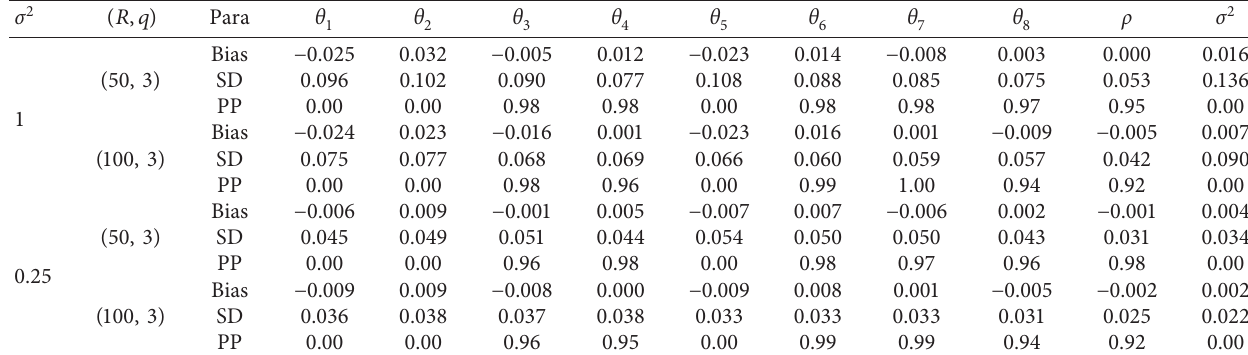
Table 2: Bayesian estimates of unknown parameters under different cases when ρ � 0 .